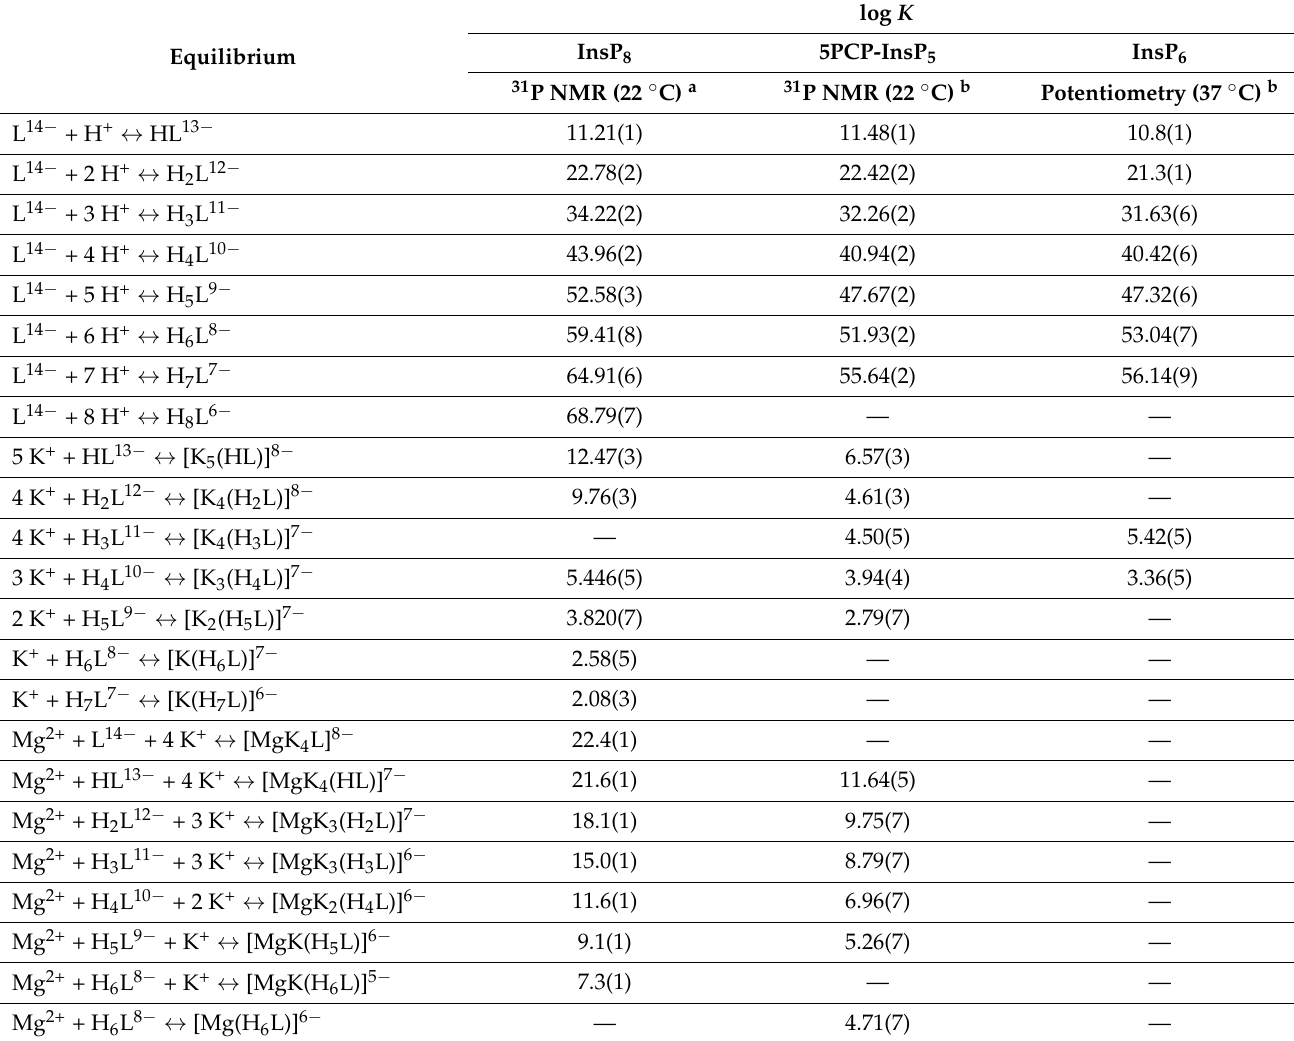
Table 1. Logarithms of the protonation and formation constants of InsP 8 ( I = 0.15 M; T = 22 ◦ C).